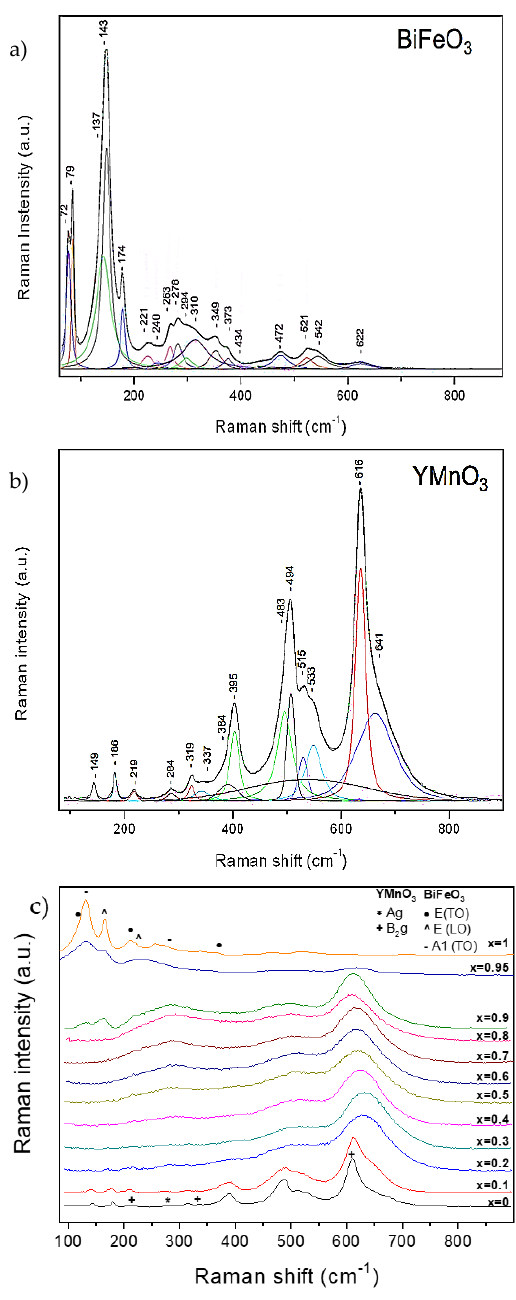
− x)YMnO 3 –xBiFeO 3